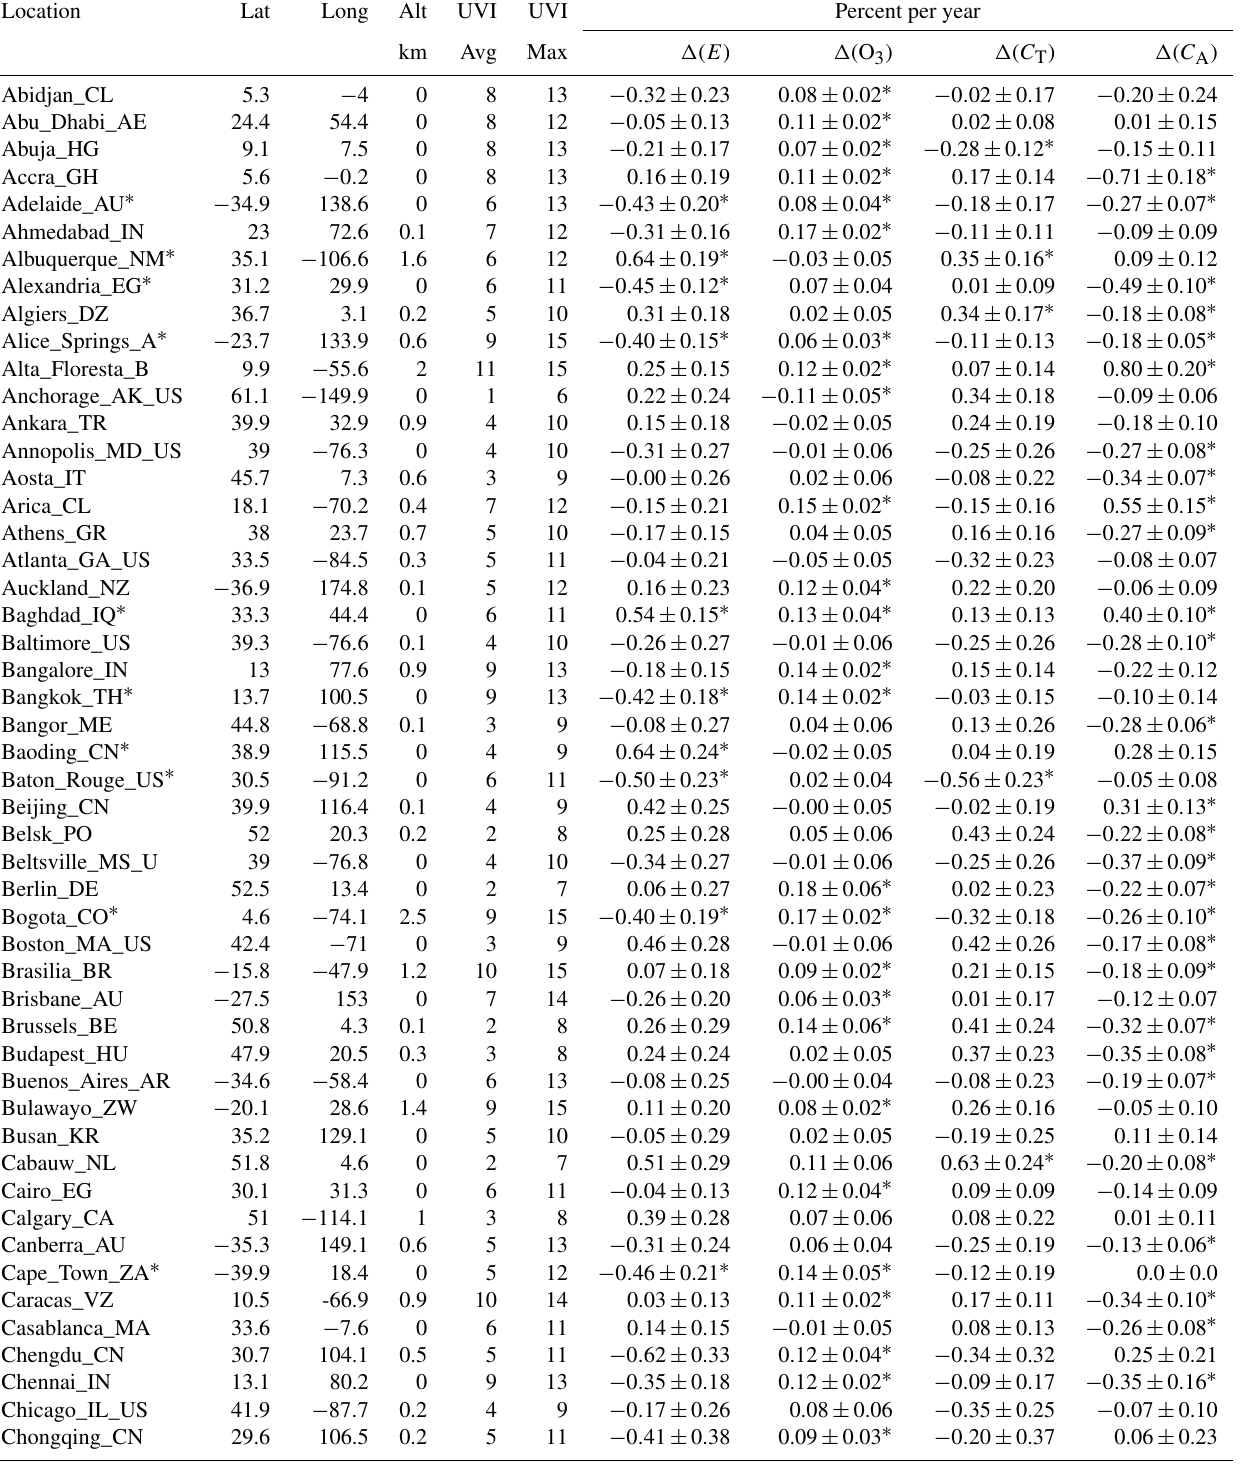
Table A4. 191 land and city locations in various countries as indicated in alphabetical order. Shown are the latitude (Lat), longitude (Long), altitude (Alt), 14-year UVI average (Avg), 14-year average maximum (Max), average (AVG), and the trends (cid:49) ( E ), (cid:49) (O 3 ), (cid:49) ( C T ), and (cid:49) ( C A ) along with their accompanying 1 standard deviation uncertainties (1 σ ) (percent per year) for the erythemal irradiance with ozone, clouds and absorbing